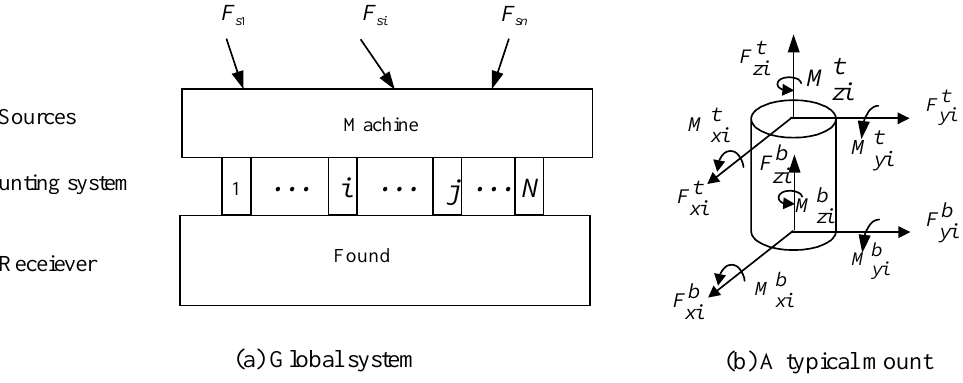
Fig. 7. Sketches of a multi-dimensional hybrid control system model: (a) Global system (b) A typical